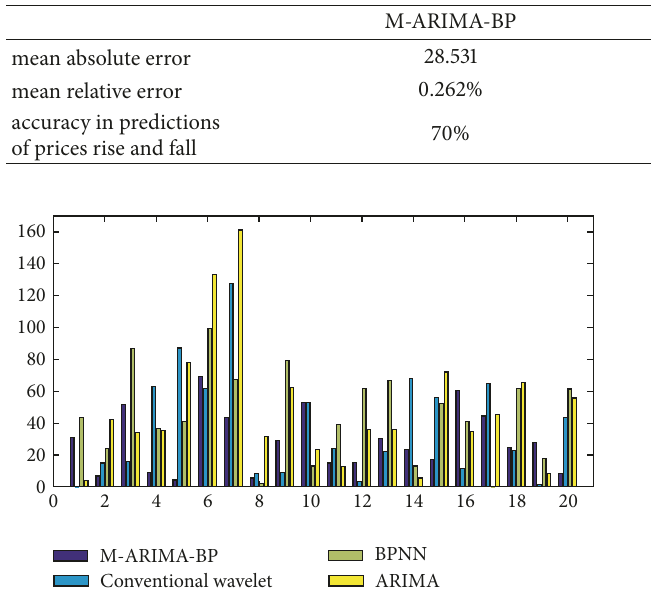
Table 5: Comparison of the prediction results of Shenzhen Stock Index.